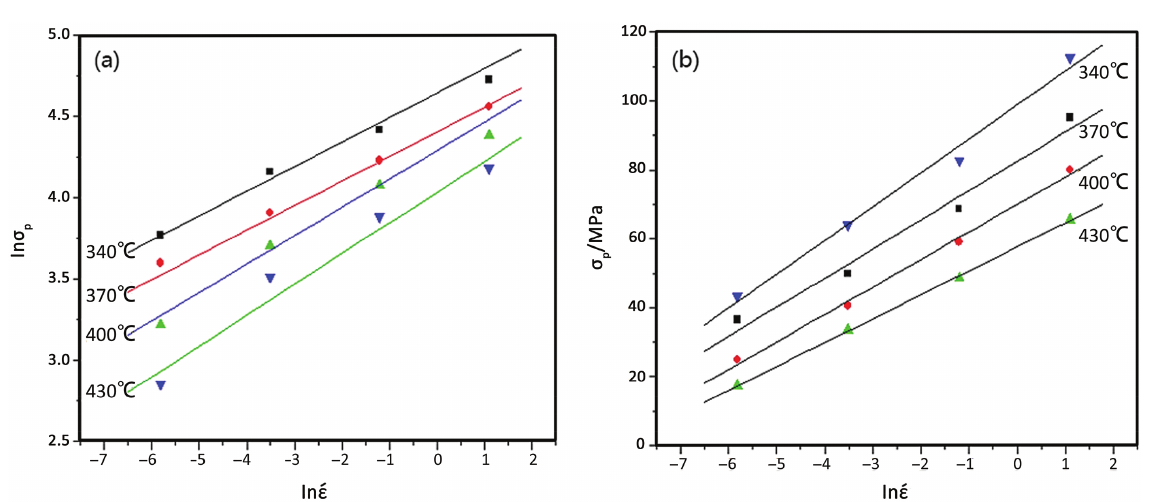
Figure 2: Relationship between peak stress and strain rate according: (a) ln _ ε − ln σ ; (b) ln _ ε − σ